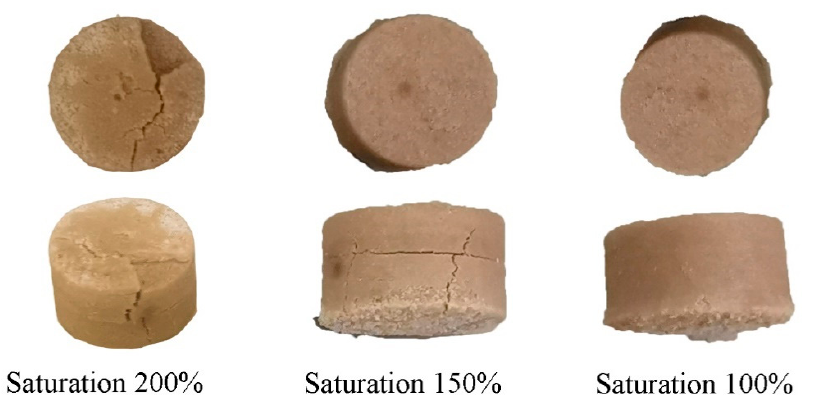
Figure 7. Images of F-BaTiO 3 samples printed by BJ with different saturation after sintering. Scale: each sample has a diameter of 15 mm and a height of 10 mm. Heating rate of 10 °C/min to 1400 °C with a dwell time of 4 h.